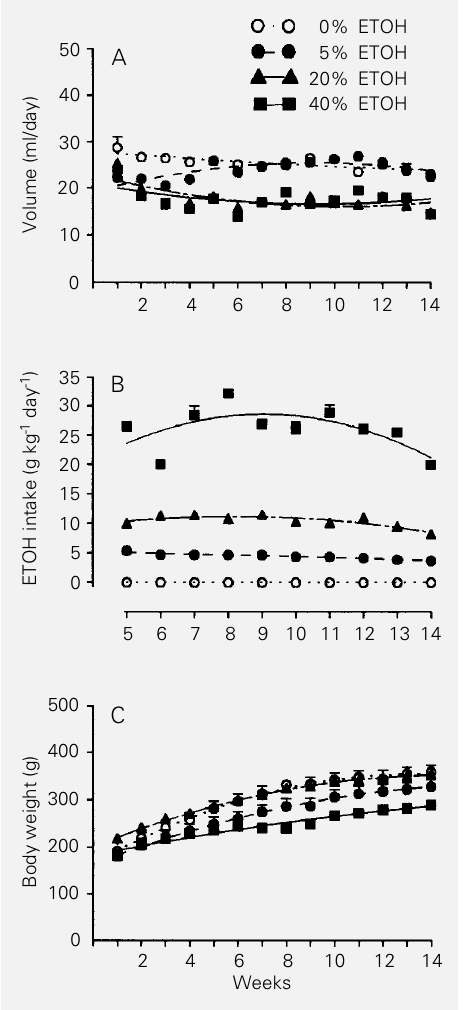
Figure 1 - Semivoluntary inter- mittent alcohol intake by rats. Data are reported as mean ± SEM for tap water (N = 11), 5% ethanol (N = 20), 20% ethanol (N = 20) and 40% ethanol (N = 18). A, Daily volume intake of alcohol solutions (ml/day); B, daily ethanol (ETOH) consump- tion per kg body weight (g kg body weight -1 day -1 ); C , body weight (g) of rats during a 14- week exposure to tap water or 5%, 20% and 40% alcohol solu-